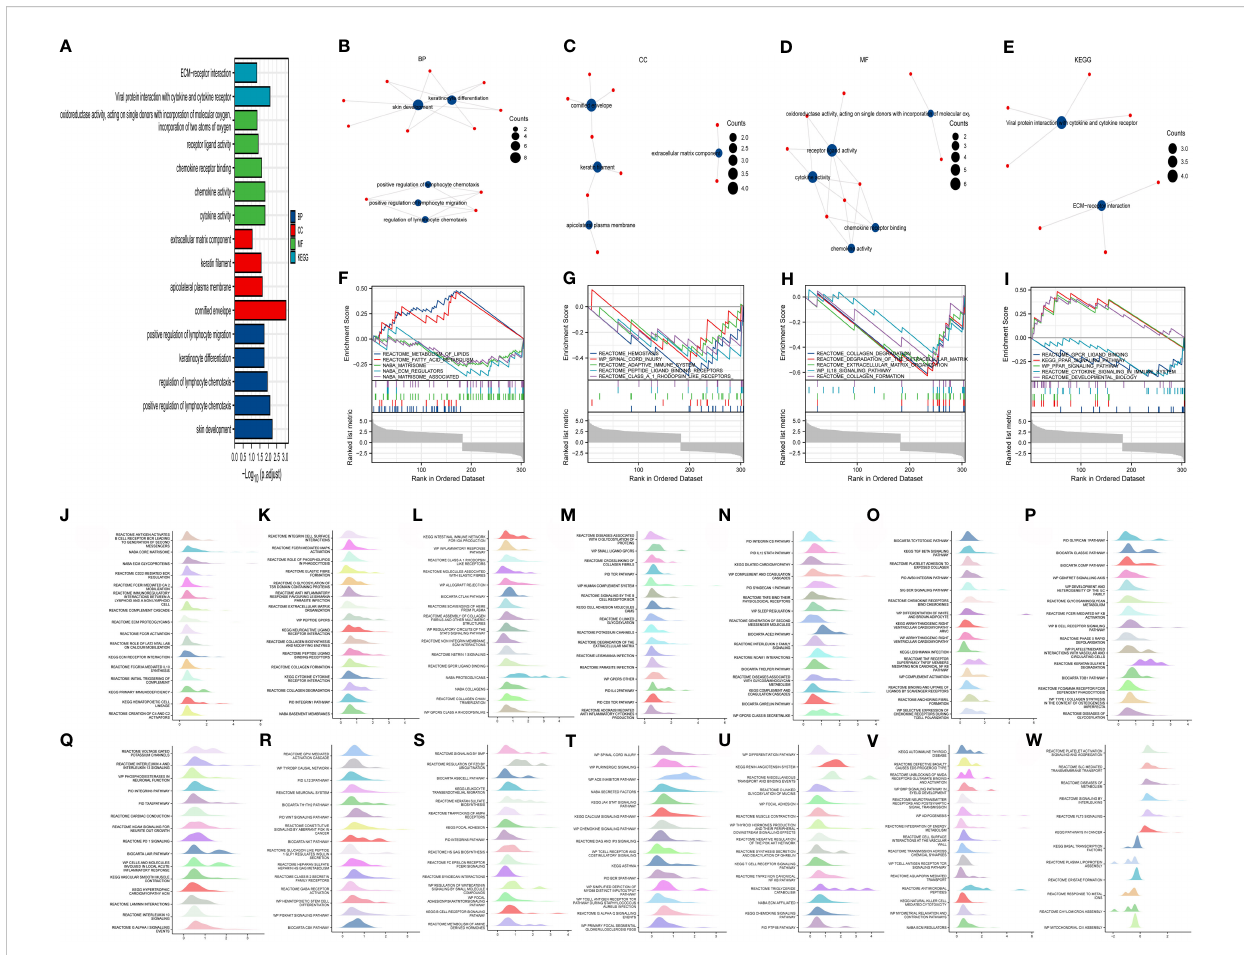
FIGURE 2 Perform enrichment analysis on 48 differentially expressed genes using the “ Cluster Pro fi ler ” R package. Under the conditions of adjusted (adj.) p ≤ 0.05 and q -value ≤ 0.2, there are fi ve biological processes (BPs), four CCs, fi ve molecular functions (MFs), and two Kyoto Encyclopedia of Genes and Genomes (KEGG) pathways (A) . The BPs are positive regulation of lymphocyte migration, keratinocyte differentiation, regulation of lymphocyte chemotaxis, positive regulation of lymphocyte chemotaxis, and skin development (B) . The CCs are extracellular matrix component, keratin fi lament, apicolateral plasma membrane, and corni fi ed envelope (C) . The MFs are oxidoreductase activity, acting on single donors with incorporation of molecular oxygen, incorporation of two atoms of oxygen, cytokine activity, chemokine activity, chemokine receptor binding, and receptor ligand activity (D) . The two KEGG pathways are viral protein interaction with cytokine and cytokine receptor, and ECM – receptor interaction (E) . The ggplot2 package was used for gene set enrichment analysis (GSEA). The top 20 pathways mainly enriched by the differentially expressed genes. (F